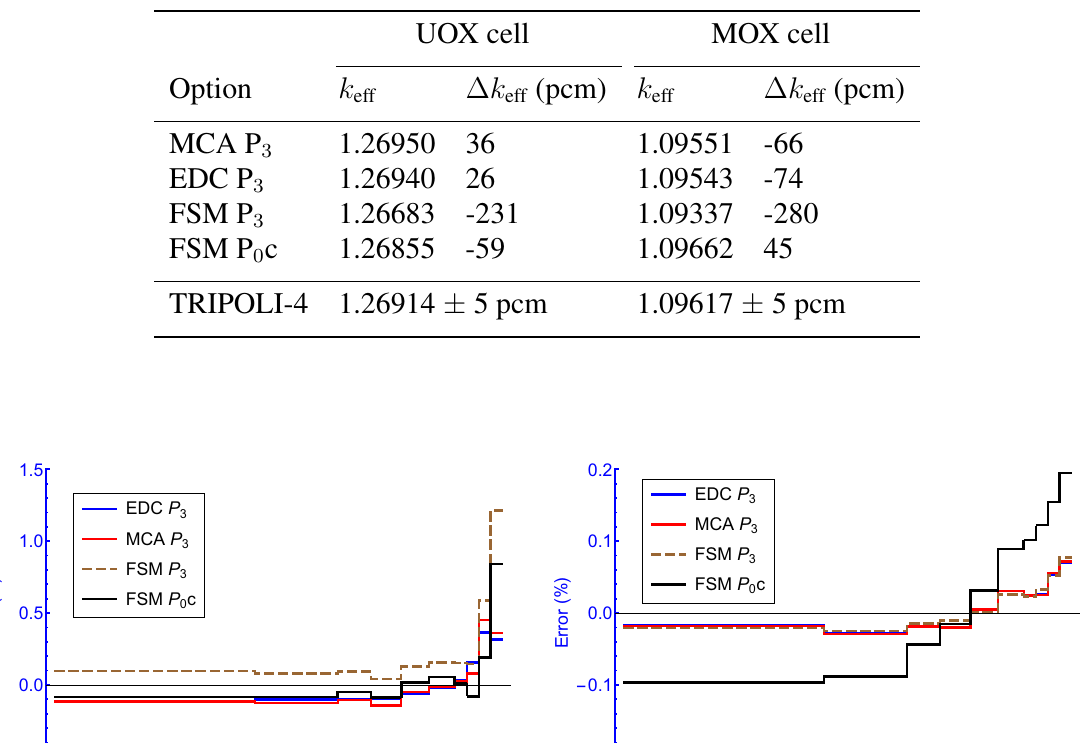
Table 1: PWR fuel cell k